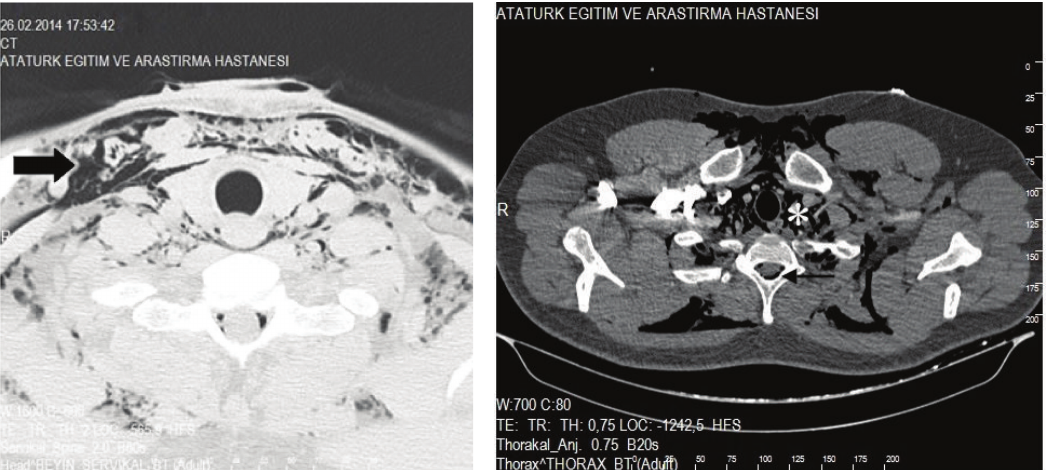
Figure 2: Diffuse subcutaneous emphysema (thick arrow), free air in the mediastinum (asterisk), and free air in the spinal canal (thin